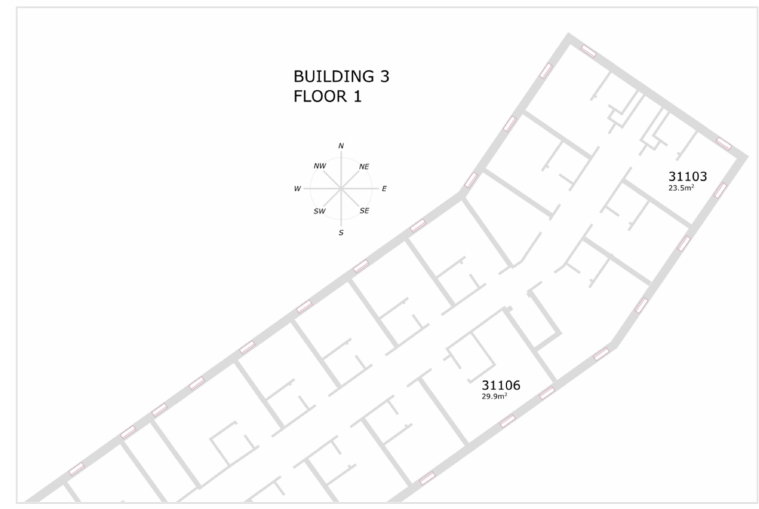
Figure 38. Case study 2: Building 3, apartments 31103 and 31105.